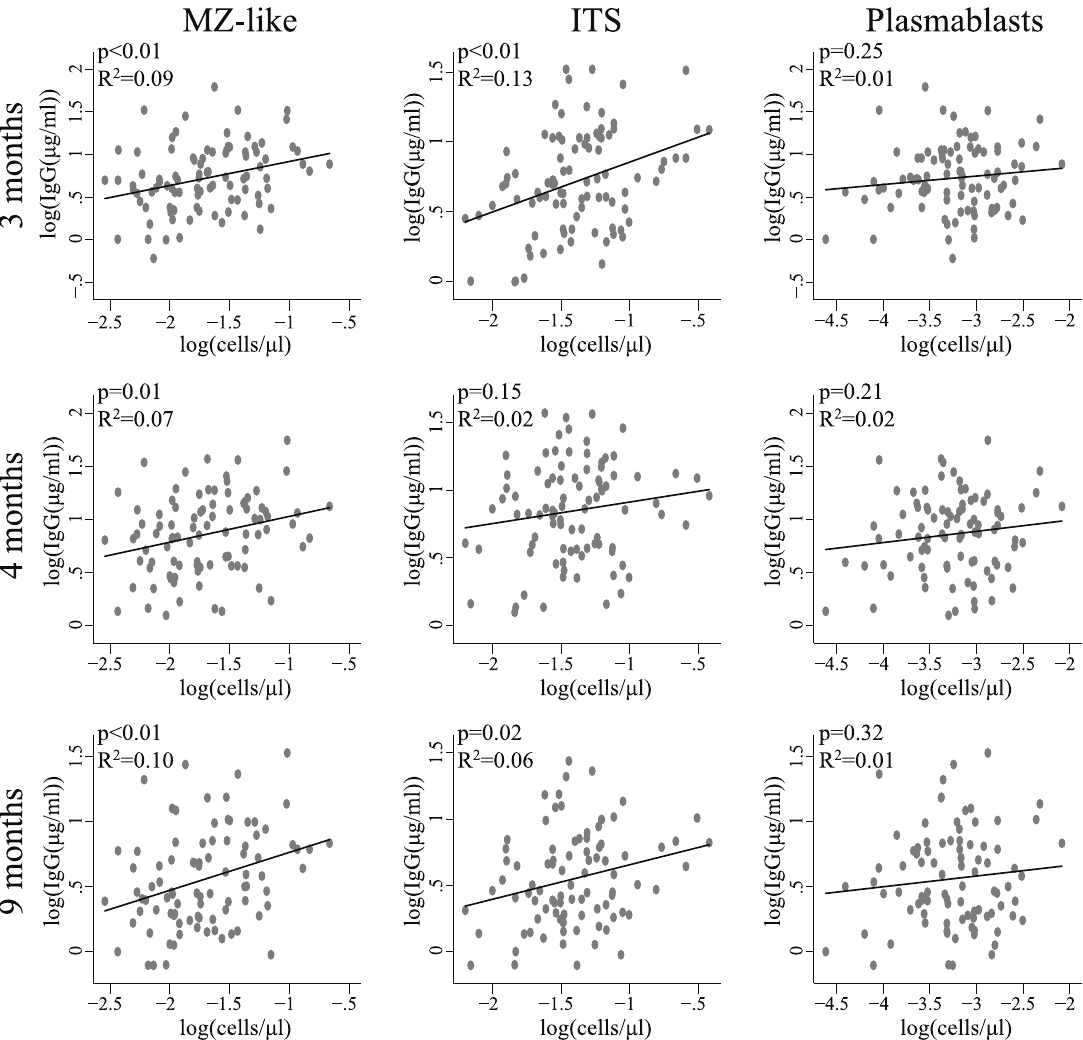
Figure 2. Linear regression plots: Pre-vaccination baseline B-cell subpopulations as predictors for IgG antibody concentration. Scatter plots with the best fitted line. Associations between the cell subset count (log cells/ m l) plotted against the IgG vaccine-specific antibody concentration (log IgG( m g/ml)) at 3, 4, and 9 months. Two outliers have been removed from the analyses of the MZ-like and three from the isotype switched B cells.